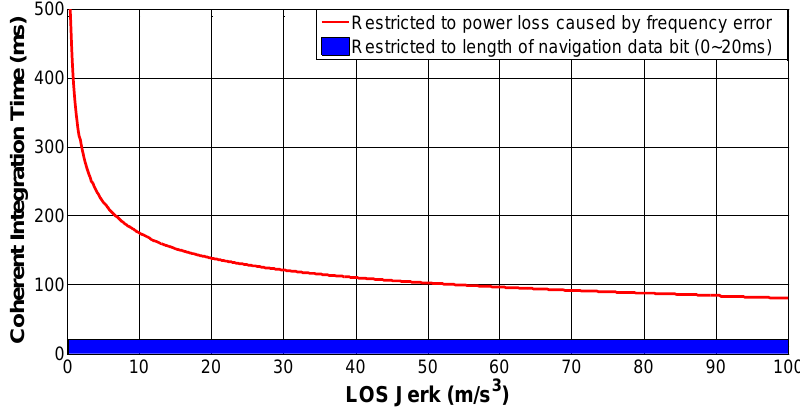
Figure 1. The selection of CIT over different LOS jerks.